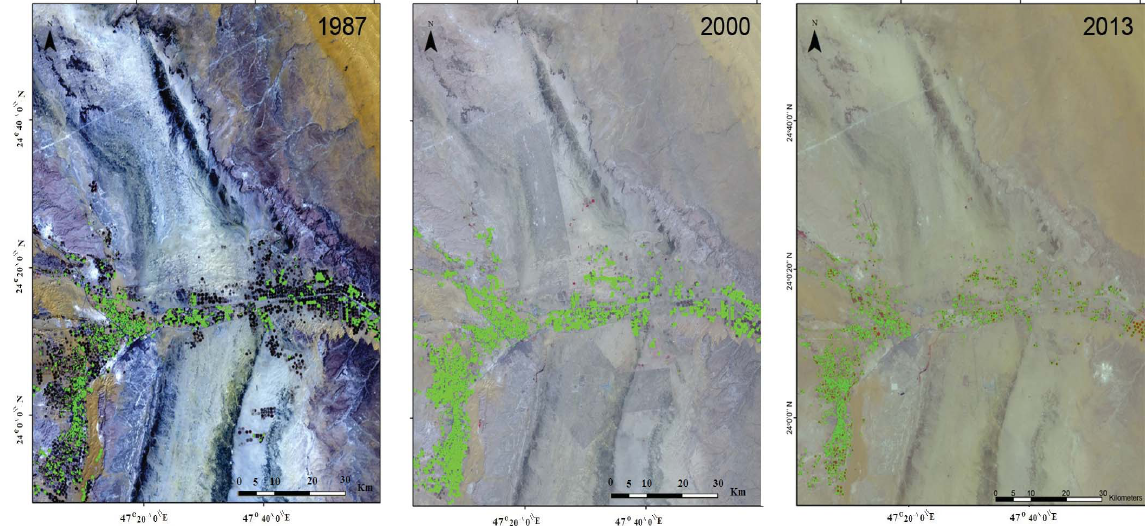
Figure 4. Vector layer for classified NDVI over Landsat satellite images from 1987, 2000, and 2013 (green is the cultivated area).